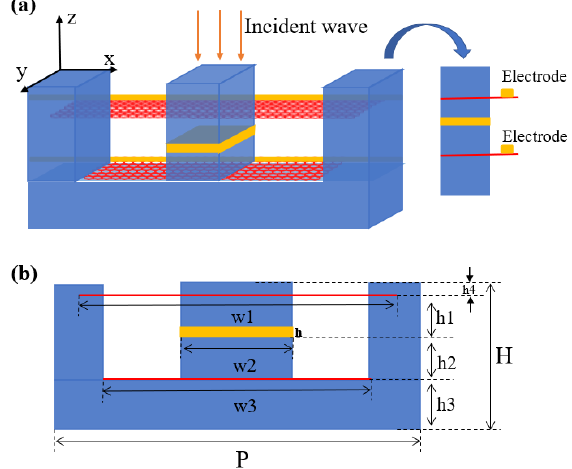
Figure 1. Schematic illustration of the proposed structure: ( a ) The whole schematic; ( b ) profile view.